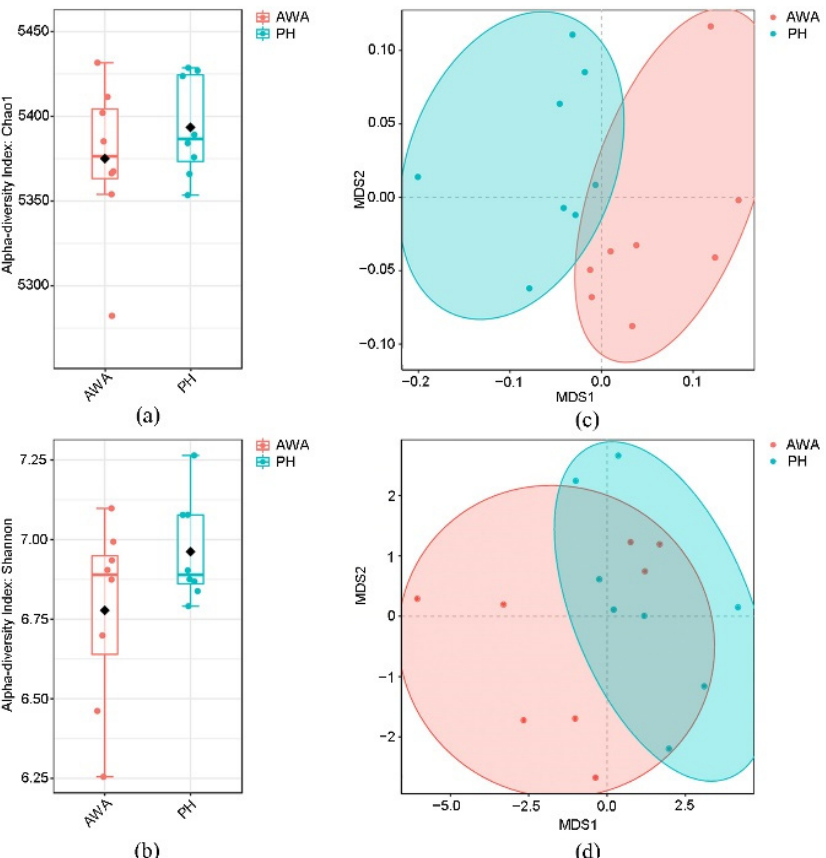
Figure 2. The intestinal microbial alpha-diversity and community composition in Przewalski’s horses (PH) and Asiatic wild asses (AWA). ( a , b ) Box plots showing; ( a ) the Chao index; and ( b ) the Shannon index of microbial species in the samples. ( c , d ) NMDS analysis showing the microbial community composition based on; ( c ) weighted UniFrac; and ( d ) unweighted UniFrac distance. Stress values lower than 0.2 indicate that the result is reliable.